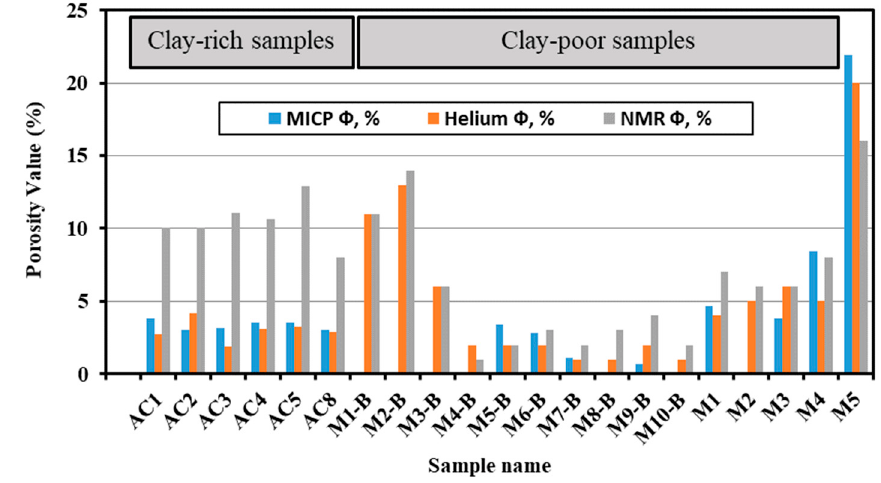
Figure 1. The porosity values obtained from mercury intrusion capillary pressure (MICP), Helium, and nuclear magnetic resonance (NMR) for two different shale formations.